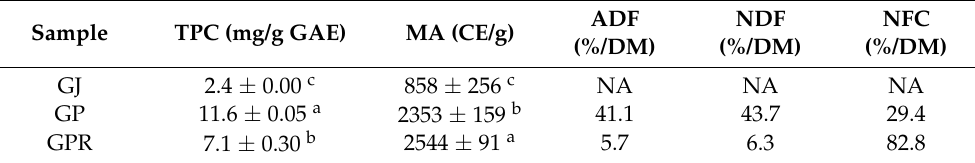
Table 2. Total polyphenol content (TPC), monomeric anthocyanins (MA), acid detergent fiber (ADF), neutral detergent fiber (NDF), and non-fiber carbohydrates (NFC) were estimated in the different grape fractions as appropriate.